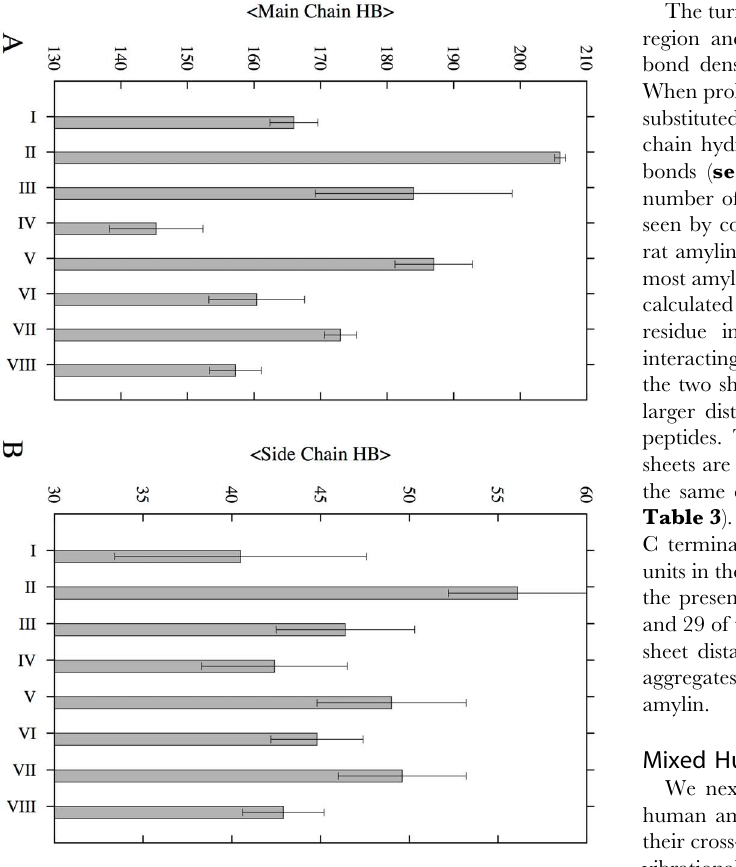
Figure 3. Average number of main chain and side chain hydrogen bonds. (A) Total number of main chain hydrogen bonds; (B) total number of side chain hydrogen bonds. Legend: (I) Single layer conformation of rat amylin, (II) single layer conformation of human amylin, (III) single layer conformation of human-rat complex, (IV) Double layer conformation of rat amylin with CC interface (V) Double layer conformation of human amylin with CC interface, (VI) Double layer conformation of rat and human amylin mixtures with CC interface, (VII) Double layer conformation of human amylin with NN interface and (VIII) Double layer conformation of rat–human amylin complex with NN interface.